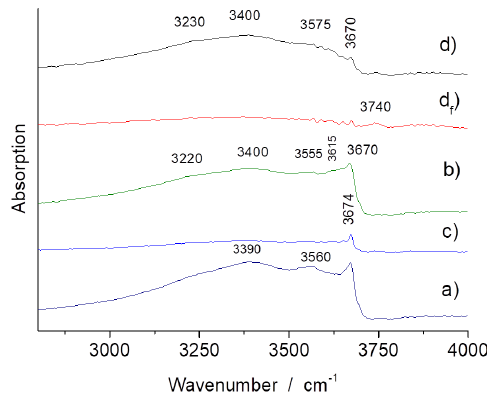
Figure 3. FTIR ATR spectra of samples ( a – d ) (see Figure 1) in the silicate framework spectral range; ( d f ) spectrum recorded on extracted asbestos fibers.